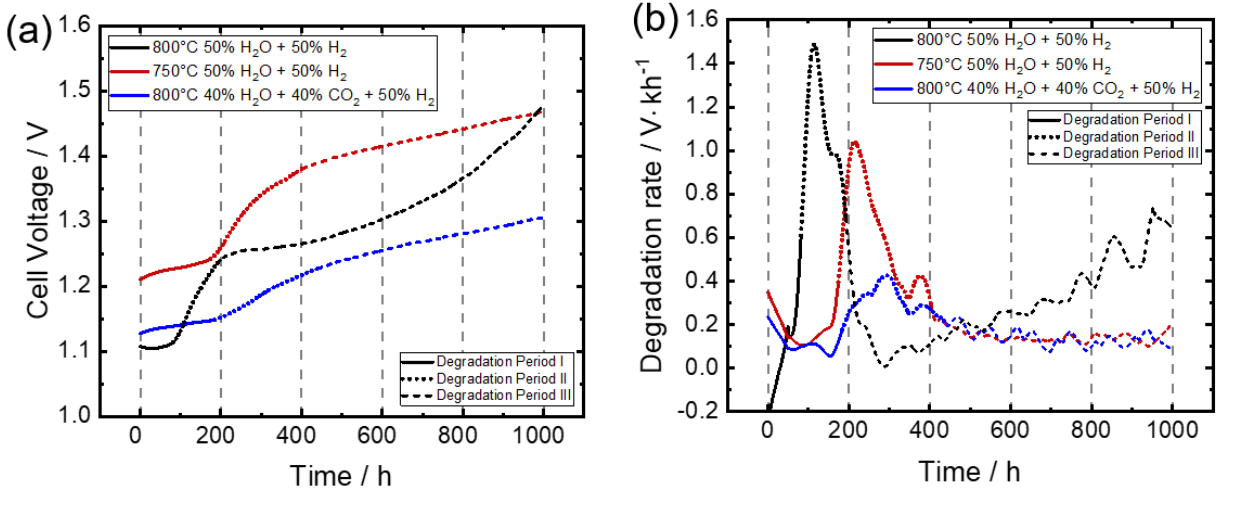
Figure 1. ( a ) Cell voltage development under galvanostatic degradation test and ( b ) degradation rate as a function of time.